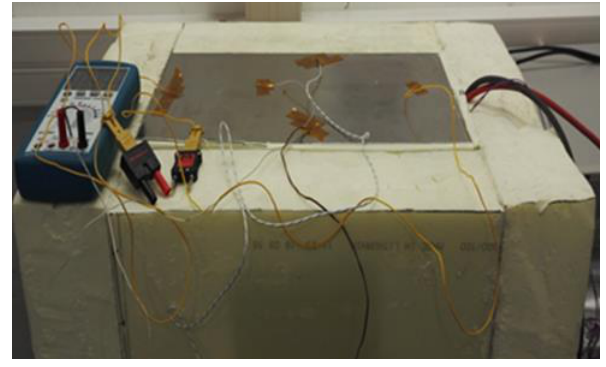
Fig. 3. The used configuration for the flat plate experiment.